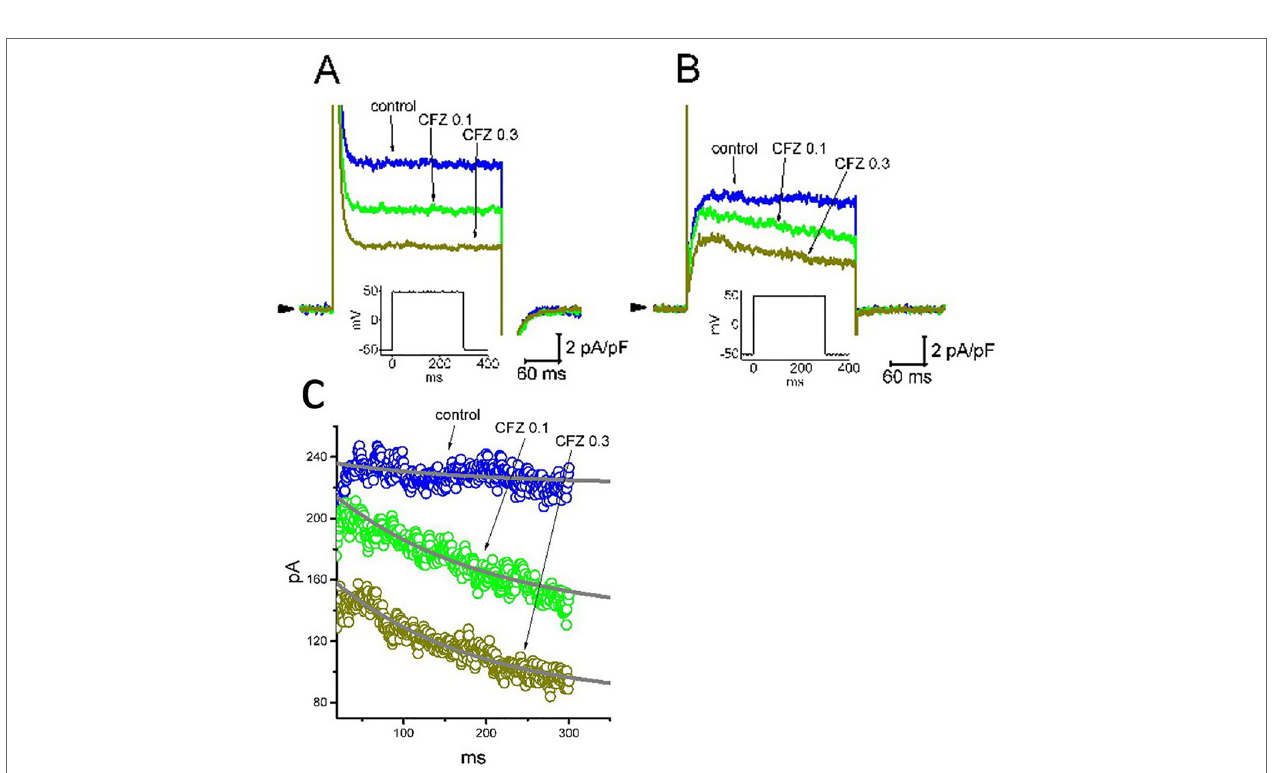
FIGURE 7 | Inhibitory effect of CFZ on I K(DR) in A7r5 vascular smooth muscle cells (A) and in H9c2 cardiac cells (B) . In these experiments, cells were bathed in Ca 2+ - free Tyrode’s solution and the pipette was filled with K + -containing solution. Superimposed I K(DR) traces recorded from either an A7r5 cell (A) or an H9c2 cell (B) were respectively obtained in the absence (control) and presence of 0.1 µM CFZ (CFZ 0.1) and 0.3 µ M CFZ (CFZ 0.3). Arrowhead indicates the zero current level, and inset shown in each panel denotes the voltage protocol applied. (C) Inactivation time course of I K(DR) in the absence and presence of 0.1 or 0.3 µM CFZ measured from H9c2 cells. Smooth curves labeled in control, CFZ 0.1 or CFZ 0.3 were least-squares fitted by single